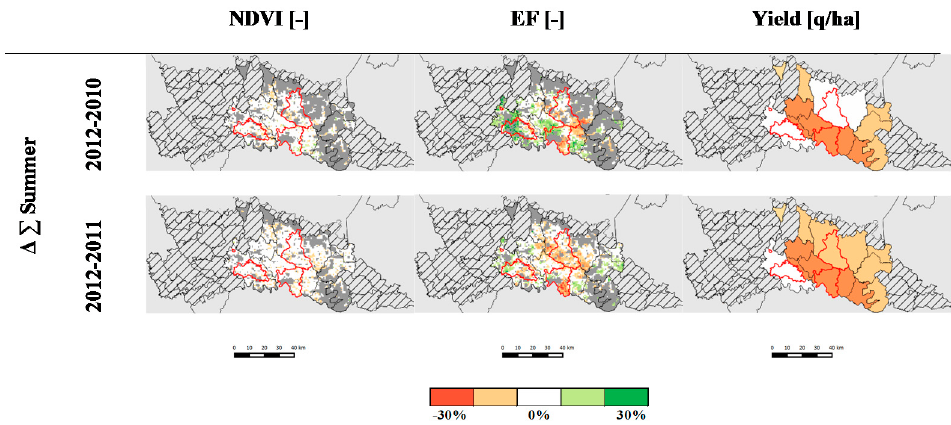
Figure 8. Percentage of the inter-annual difference ( Δ∑ Summer [%]) of cumulated NDVI , EF and Yield. Dark grey color shows areas with no data (cloud cover), grey lines mask agronomic districts where corn covers less than 60% of agricultural surface. Red polygons are the corn districts analyzed (C1, C2 and C3). Table 3. ( a ) Results of ANOVA and post-hoc Tukey test ( α = 0.001) for summer cumulated EF and NDVI among years (2010–2011) (n = cardinality; µ : district average value); ( b ) official annual corn yield statistics for the 2010–2012 period and last ten years average (2001–2011). Codogno Plain Central Bresciana